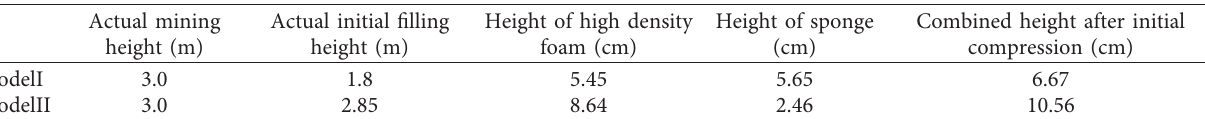
Table 4: Similar model experiment scheme and combination design of foam and sponge for two models.